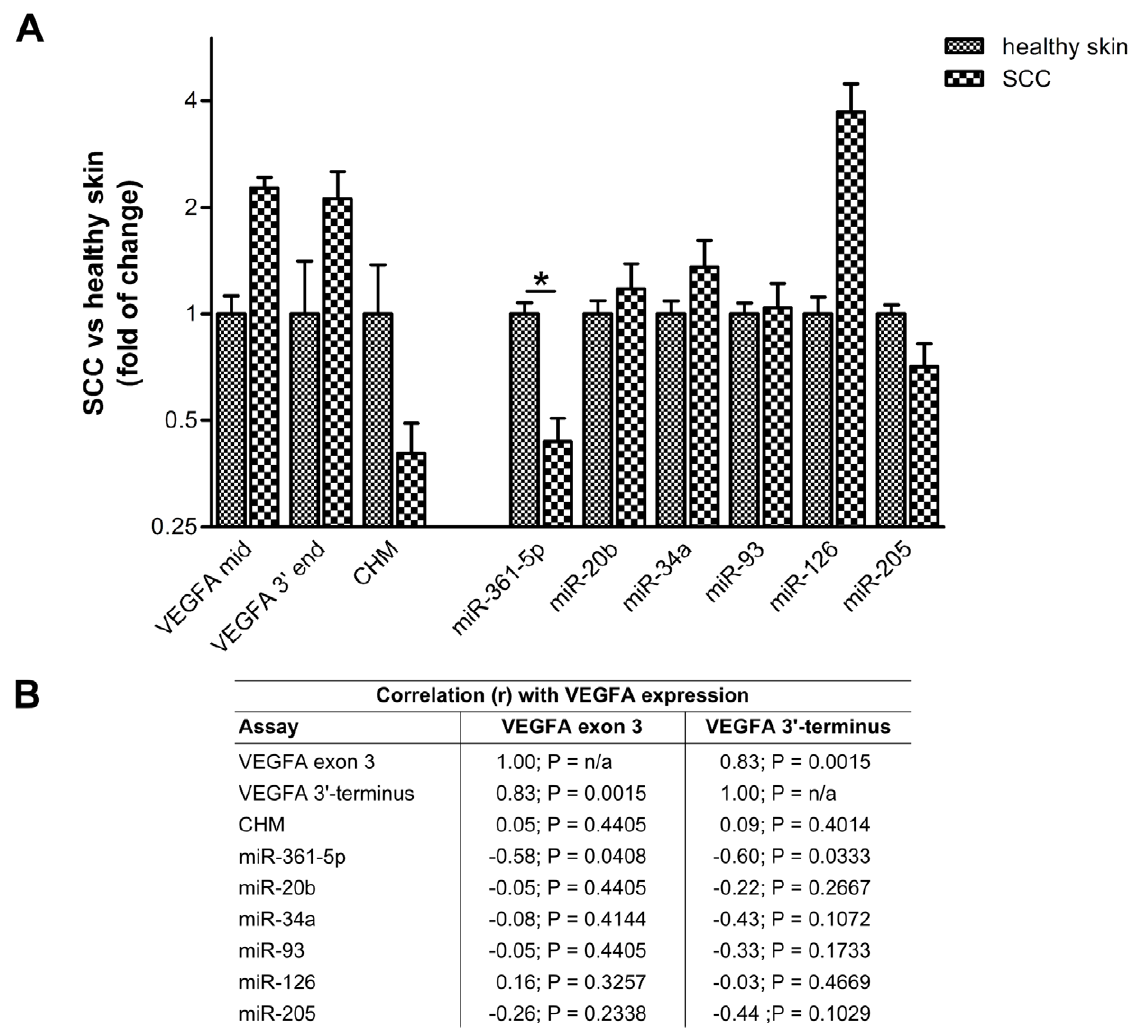
Figure 4. Relative changes in expression of selected mRNAs and mature miRNAs in healthy skin and SCCs. For each group, five samples were analyzed by qRT-PCR, representing ten individuals. Experiments were performed in quadruplicates. Data are based on C T values normalized to ACTB and RNU6B for mRNAs and miRNAs, respectively. (A) Fold differences in expression relative to average of expression in healthy skin samples 6 S.D. are indicated for each assay on a logarithmic scale. The Mann-Whitney U test was used to calculate P values (two-tailed; the single asterisk denotes a P value , 0.05). (B) Based on the normalized expression levels, Spearman rank correlation coefficients (r) between relative expression levels of VEGFA and each of the indicated miRNAs were calculated over all samples. P values (one-tailed) are